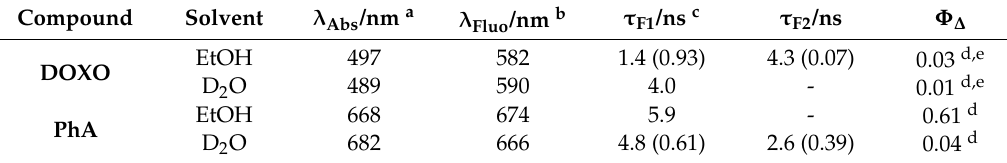
Table 1. Optical and photochemical properties of the compounds studied in this work. Compound